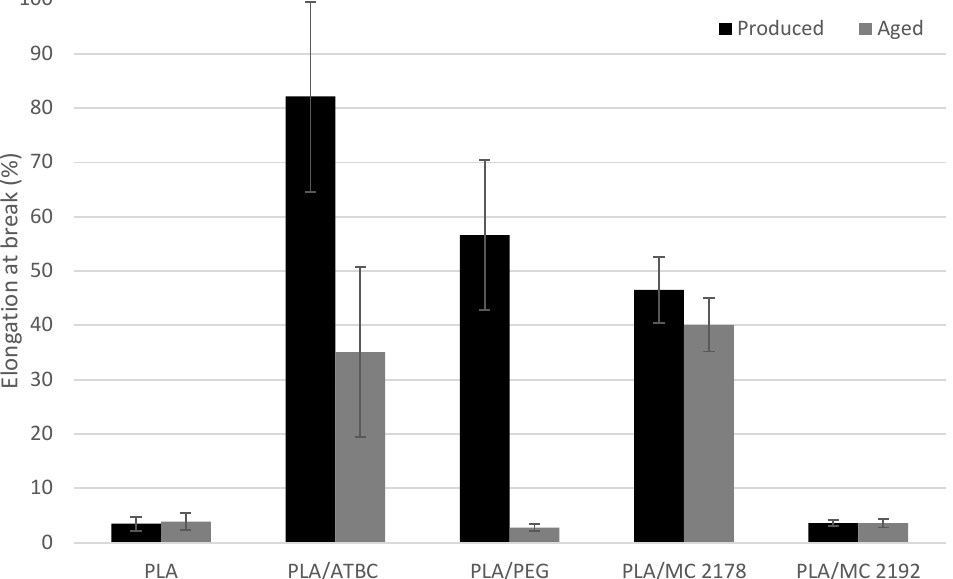
Figure 3. The evaluated results of tensile modulus for as-produced and aged PLA films. The results of the mechanical properties of aged films were compared to as-produced ones, and no changes in neat PLA films could be found. However, the differences in re- sults of as-produced and aged plasticized PLA films could be observed. The aged PLA films plasticized with ATBC showed a significant decrease in elongation (57%), a consid- erable decrease in tensile modulus (25%), and minimal changes in tensile strength (4%). This drop could be ascribed to structural changes, the degradation process (chain scis- sion), and the migration of plasticizer. The chain scission evoked a reduction in intermo- lecular forces and increased the mobility of the system. Consequently, tensile strength and modulus decreased. Furthermore, the enhancement of brittleness, and decrease in elon- gation and viscosity, is characteristic of the degradation process. The migration of ATBC, due to the lower content of plasticizer, could cause the ductility and fracture resistance to decrease. On the contrary, tensile strength, modulus, and viscosity will increase [34]. Re- garding the stated results, the degradation (chain scission) could be ascribed as the pri- mary reason for the change in properties of aged PLA/ATBC films. This confirmed the result of Rapa et al. [31,35], where a low migration of ATBC at 20 wt. % in PLA was ob- served. The greatest changes in mechanical properties were found for aged PLA/PEG